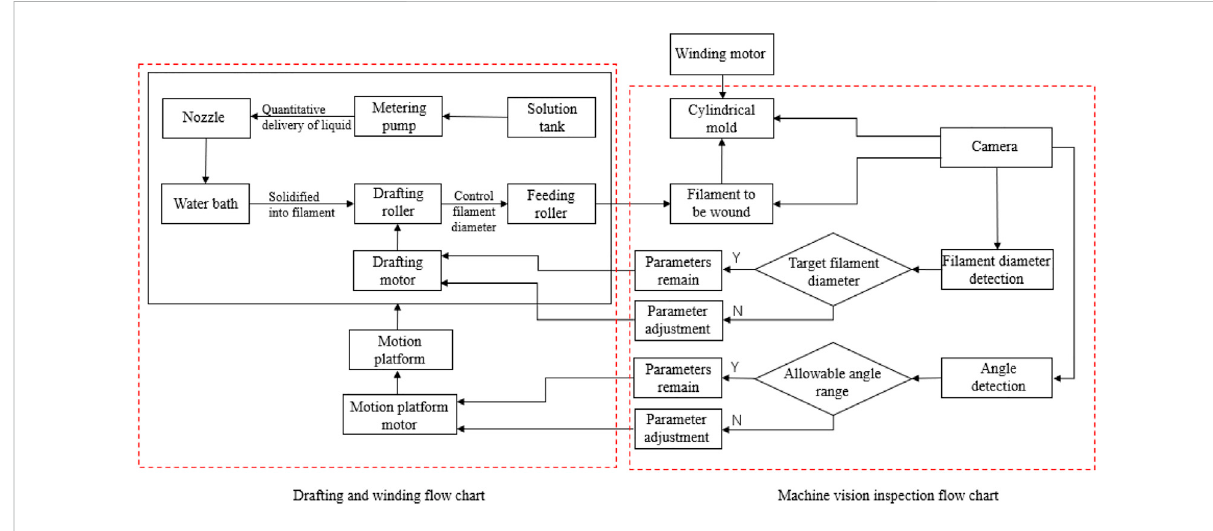
FIGURE 3 Block diagram of PU tube preparation and visual